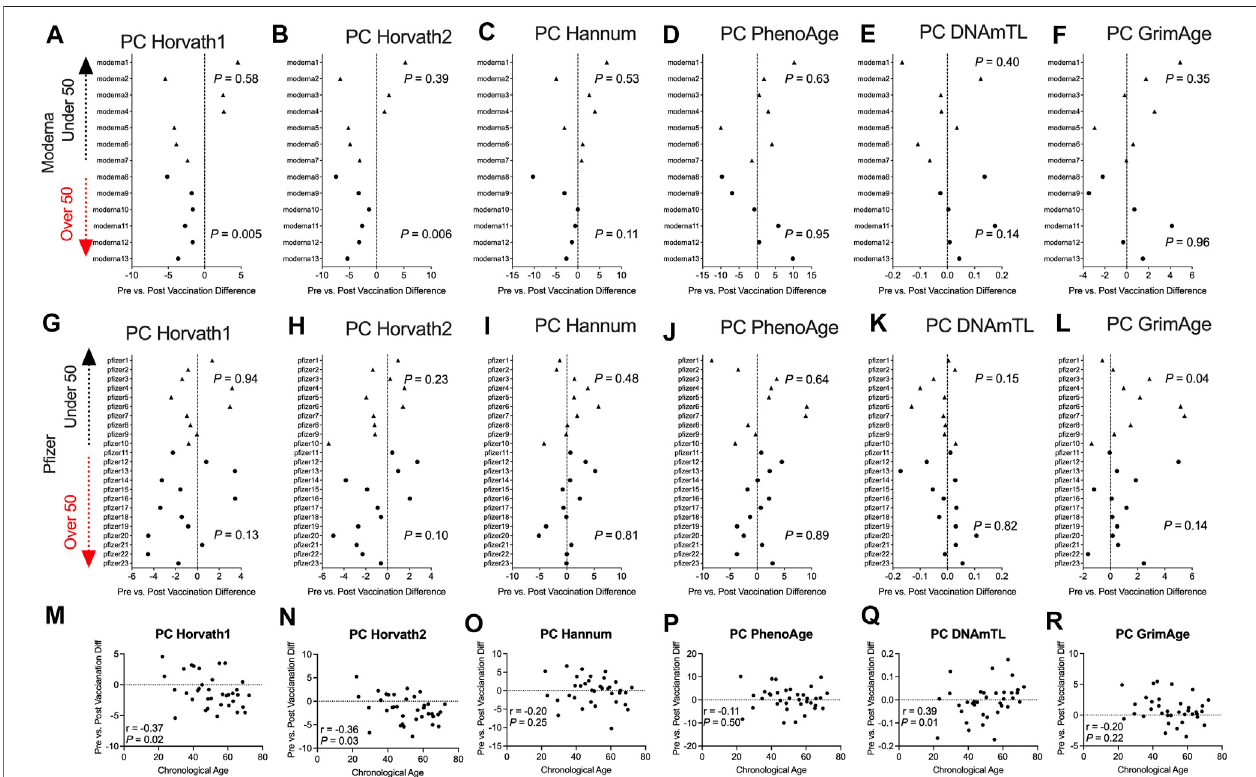
FIGURE7| ModernamRNACOVID-19vaccinationdecreasesprincipalcomponent-basedepigeneticageinindividualsover50 (A – F) .Plotsdisplayingthechange inprincipalcomponent-basedepigeneticclockageestimatesinindividualspre-vs.post-mRNAModernavaccinationstrati fi edbyage.Trianglesdisplayparticipantsless than 50 years of age and circles display participants over 50 years of age. (G – I) . Plots displaying the change in principal component-based epigenetic clock age estimates in individuals pre- vs. post-mRNA P fi zer vaccination strati fi ed by age (M – R) . Correlations between chronological age and pre- vs. post-mRNA vaccination change in PC-based epigenetic clock